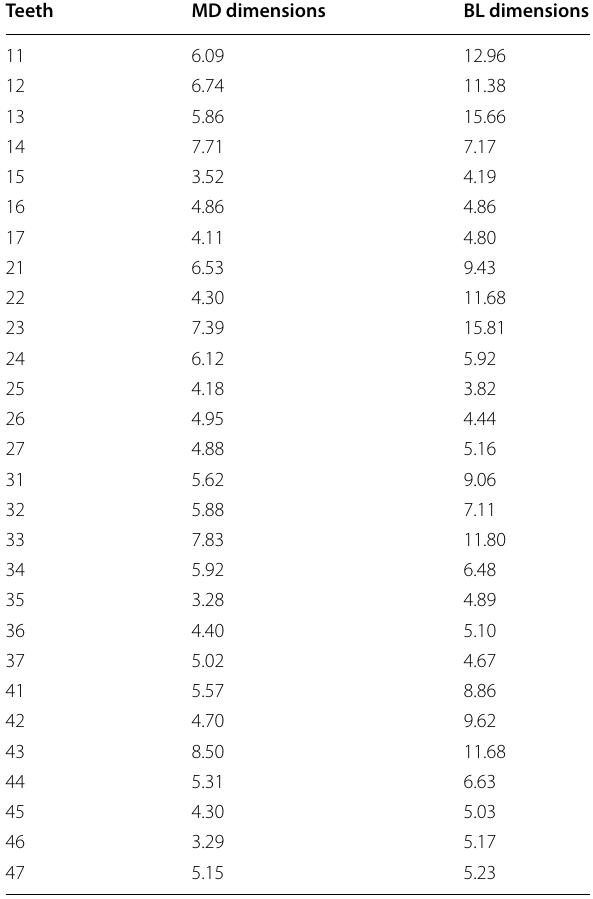
Table 3 Percentage of dimorphism of maxillary and mandibular teeth